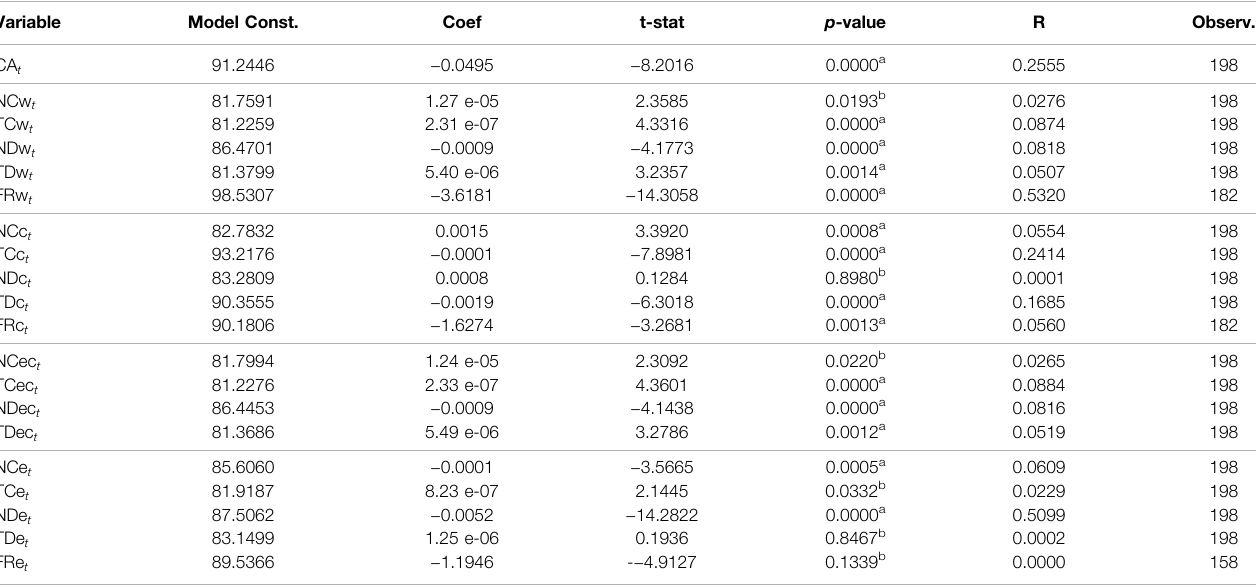
TABLE 6 | Bivariate regression models for COVID-19 effect on S&P Emerging LargeMidCap E.S.G.